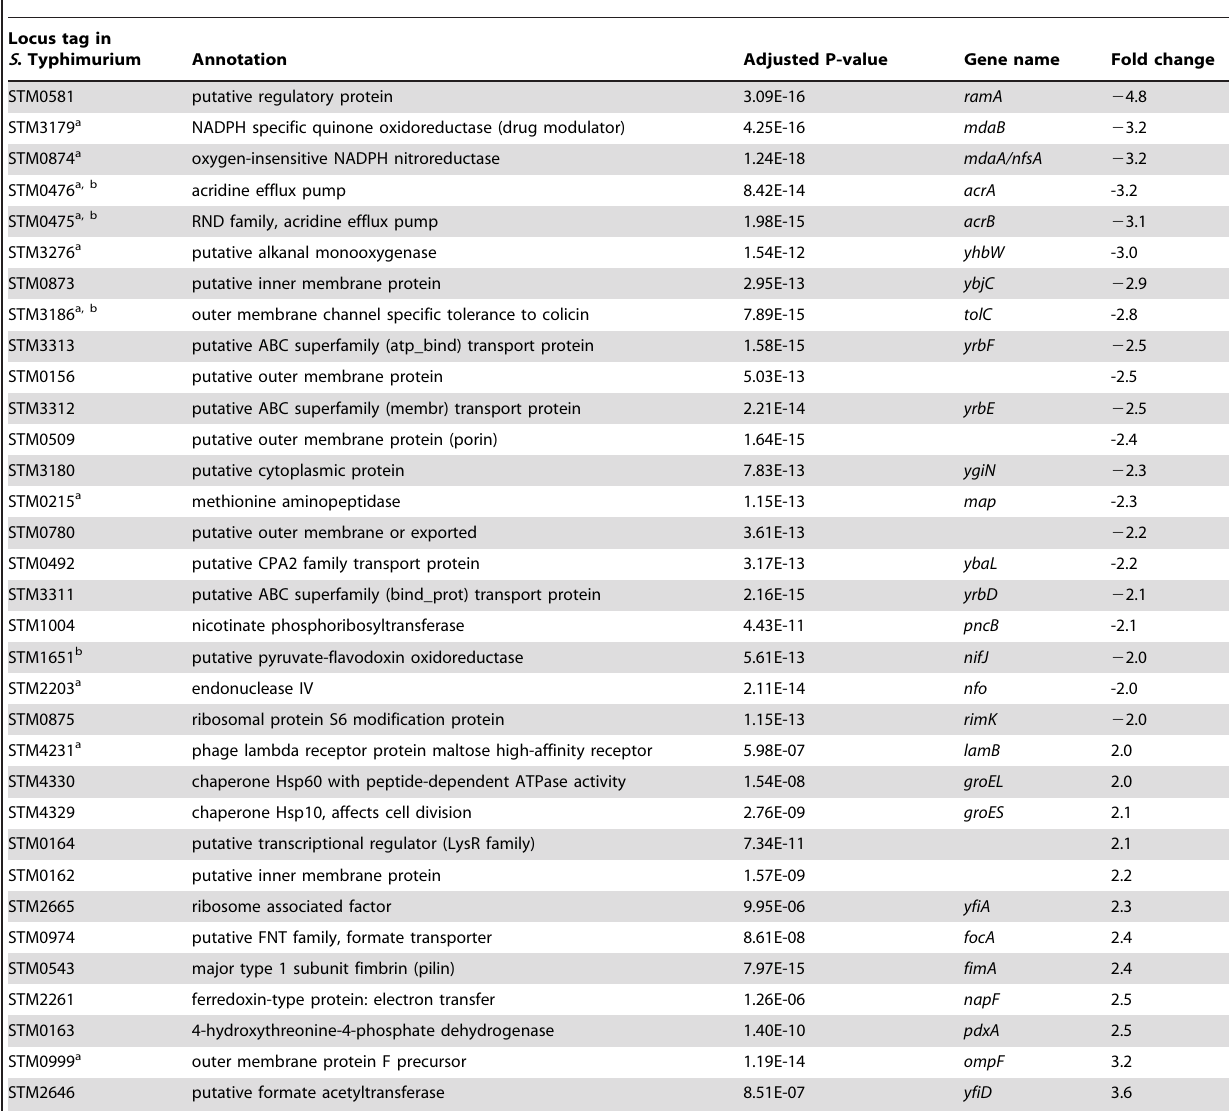
Table 1. Gene expression variations greater than or equal to 2-fold due to ramA inactivation in comparing S . Typhimurium strain LTL ramA::aph to S . Typhimurium strain LTL.